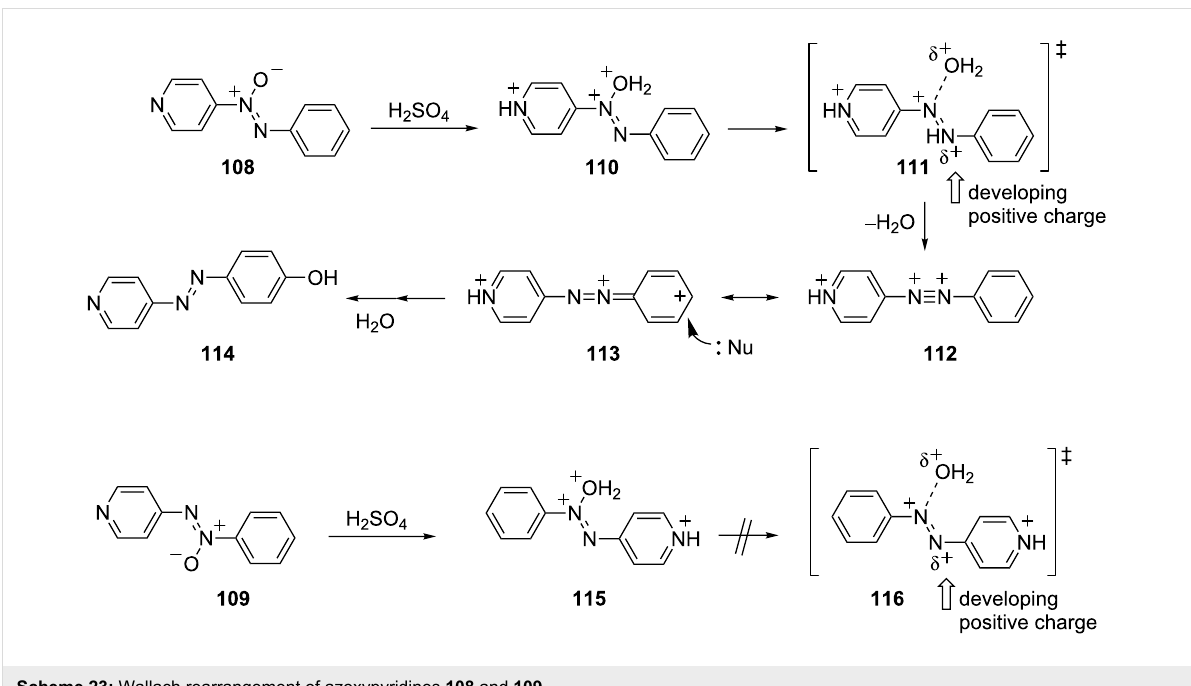
Scheme 23: Wallach rearrangement of azoxypyridines 108 and 109